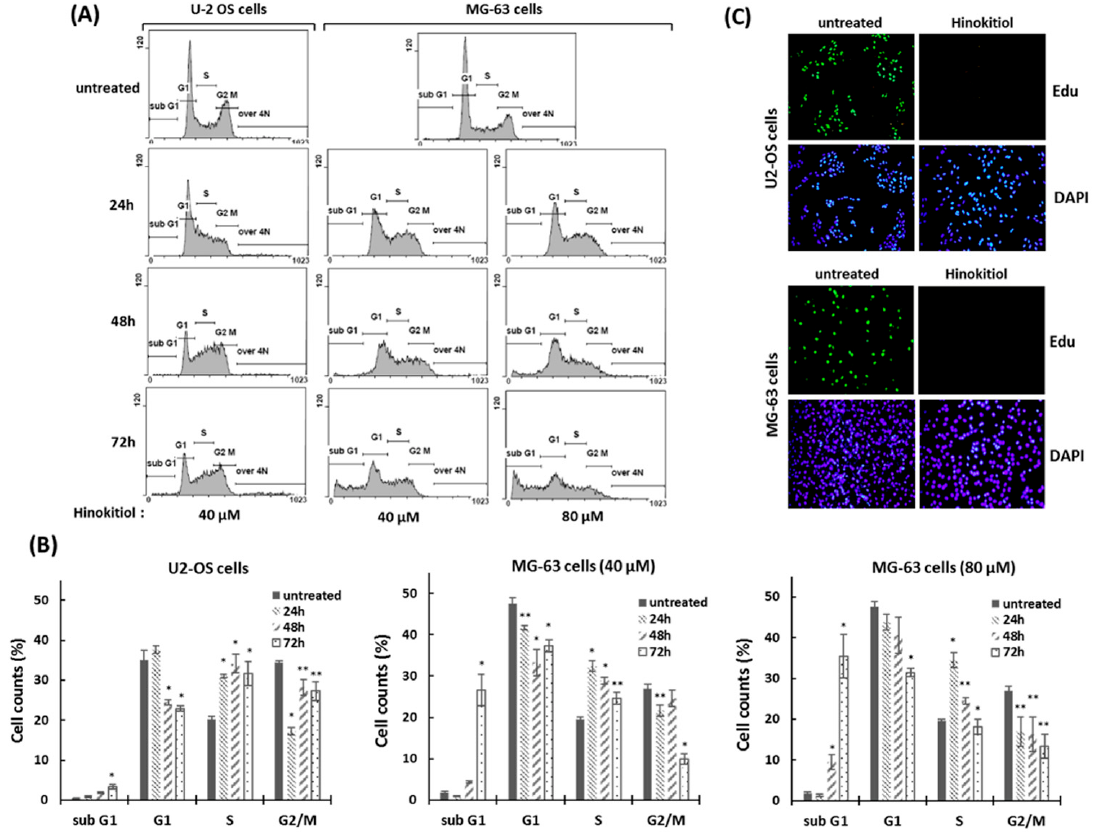
Figure 2. Hinokitiol induces S phase arrest in osteosarcoma cell lines. ( A ) Hinokitiol treatment results in accumulation of osteosarcoma cells in the S phase of the cell cycle. U-2 OS and MG-63 were incubated with hinokitiol for 24, 48, or 72 h. DNA contents of cells were determined by propidium iodide (PI) staining using flow cytometry. Quantitative results of different cell populations were revealed ( B ). * p < 0.001, and ** p < 0.01. ( C ) Hinokitiol suppresses proliferation of osteosarcoma cell lines. U-2 OS and MG-63 cells were incubated with hinokitiol (40 µ m) for 24 h. New DNA synthesis in these cells was evaluated through the Edu incorporation assay.